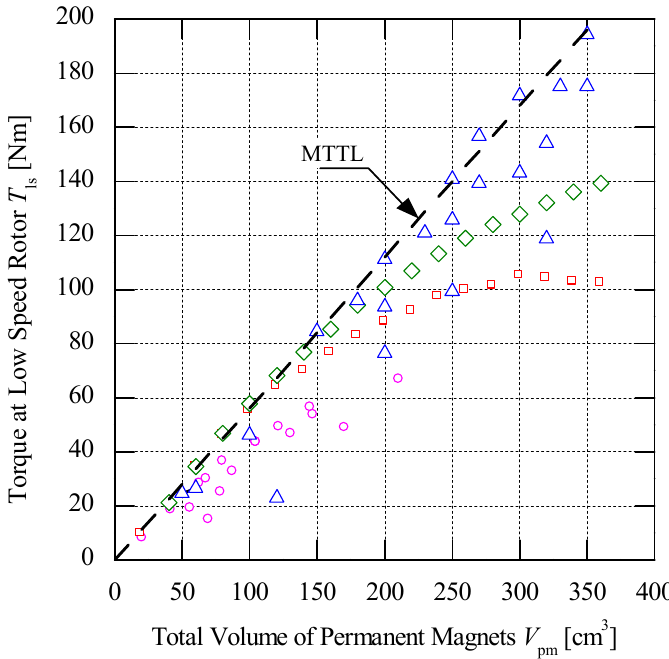
Figure 3. The characteristic of transmission torque against the total volume of PMs.